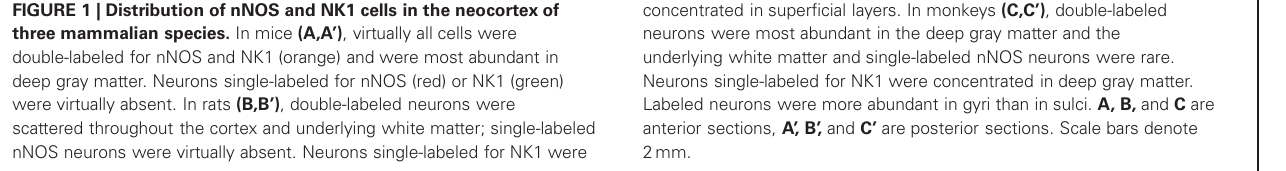
concentrated in superficial layers. In monkeys (C,C’) , double-labeled neurons were most abundant in the deep gray matter and the underlying white matter and single-labeled nNOS neurons were rare. Neurons single-labeled for NK1 were concentrated in deep gray matter. Labeled neurons were more abundant in gyri than in sulci. A, B, and C are anterior sections, A’, B’, and C’ are posterior sections. Scale bars denote